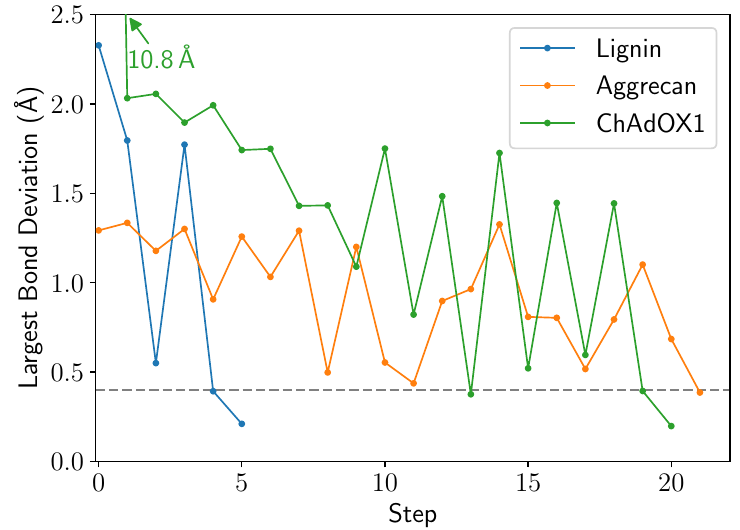
Figure 7. Example traces highlighting the eventual convergence for all structures after repeated cycles of the LBE procedure. In this instance, step 0 is the initial structure, prior to minimization, while the subsequent steps follow the primary workflow outlined in Figure 2. The 0.4Å convergence criteria is highlighted by a gray dashed